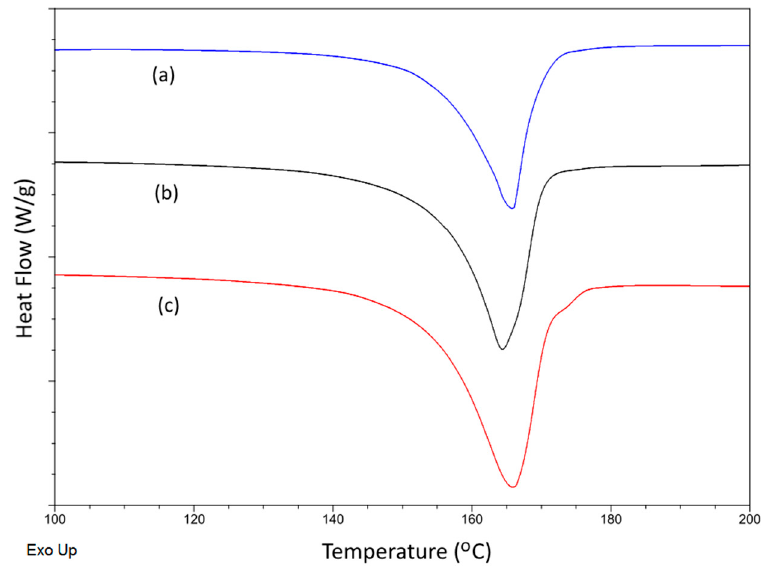
Figure 8. DSC thermograms of PVDF-TiO 2 membranes prepared at ( a ) 70 °C and ( b ) 10 °C, and of ( c ) PVDF membrane prepared at 10 °C. Table 2. Melting temperature (T m ), total crystallinity (X c ) and fraction of α crystalline form (F α ) of membranes (the number after membrane name indicates the temperature (°C) at which it was prepared).